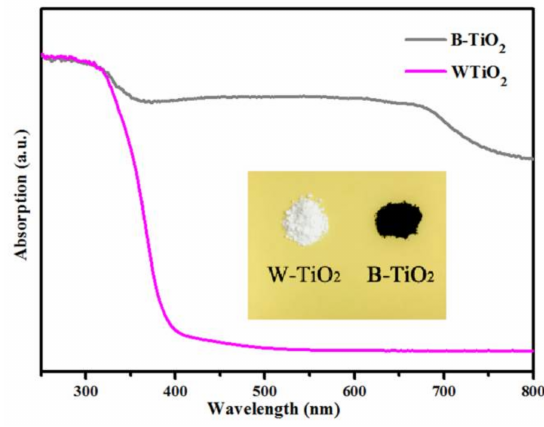
Figure 1. UV-Vis absorption spectra of black B-TiO 2 and W-TiO 2 nanoparticles. The insert is a photograph of B-TiO 2 and W-TiO 2